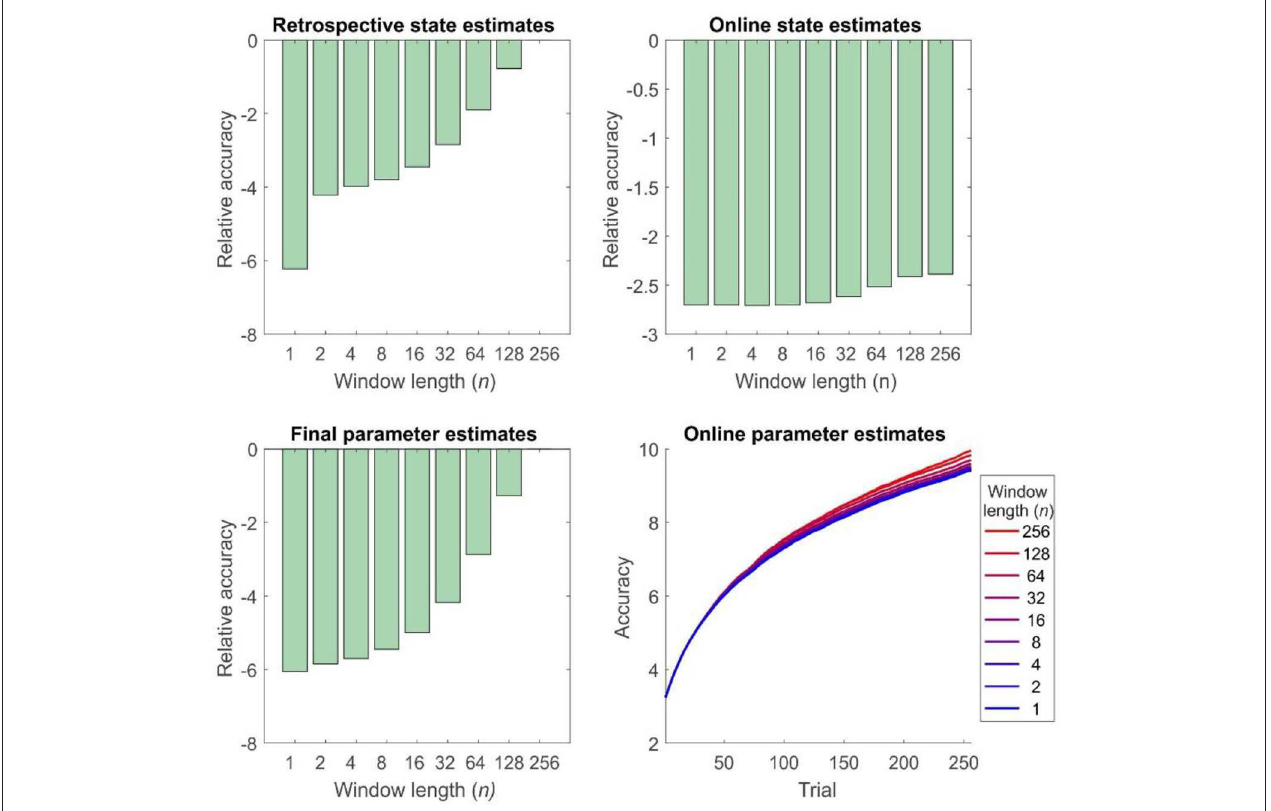
FIGURE 6 | Accuracy of inference and learning for random HMMs (see “Simulations” for more details). In general these mirror the results for the reversal task ( Figure 5 ), but the quantitative differences are smaller, perhaps reflecting the greater number of states and parameters to be estimated (Accuracy is quantified as the log likelihood assigned to the true sequence of states or the true parameter value by the agent, averaged across simulations). Top left panel: accuracy of state estimation increases with window length, becoming identical for online and offline agents with the same effective window length (256 trials). Top right panel: accuracy of online (filtered) state estimates relative to the filtered state estimates of an offline agent. Accuracy increases with window length, but never becomes equivalent to that of an offline agent. Bottom left panel: accuracy of final parameter estimates relative to the performance of an offline agent. As the window length employed increases, so does accuracy, becoming equivalent for online, and offline agents with the same effective window length. Bottom right panel: average accuracy of parameter estimates across trials. Accuracy of parameter estimation increases with window length, and these differences progressively appear as the session goes